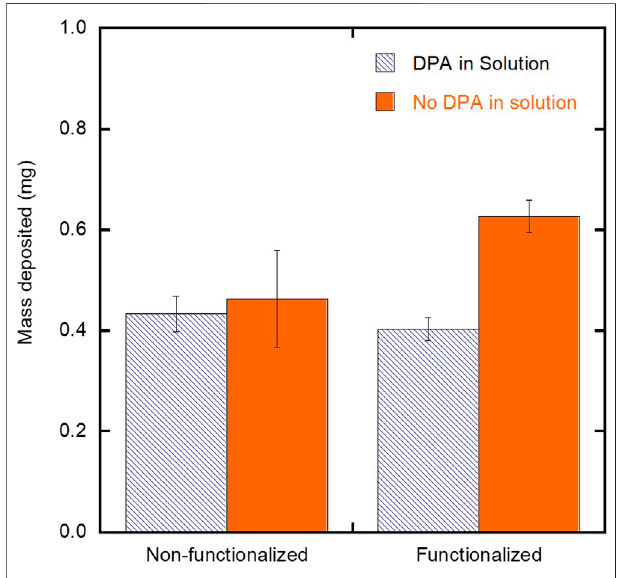
FIGURE7| Effect ofSH-PEG-DPA chelatingagentinthesuspensionon the mass deposited for EPD on non-functionalized and SH-PEG-DPA functionalized substrates. The concentration of SH-PEG-DPA in the suspension was 0 or 0.5 g/L SH-PEG-DPA.